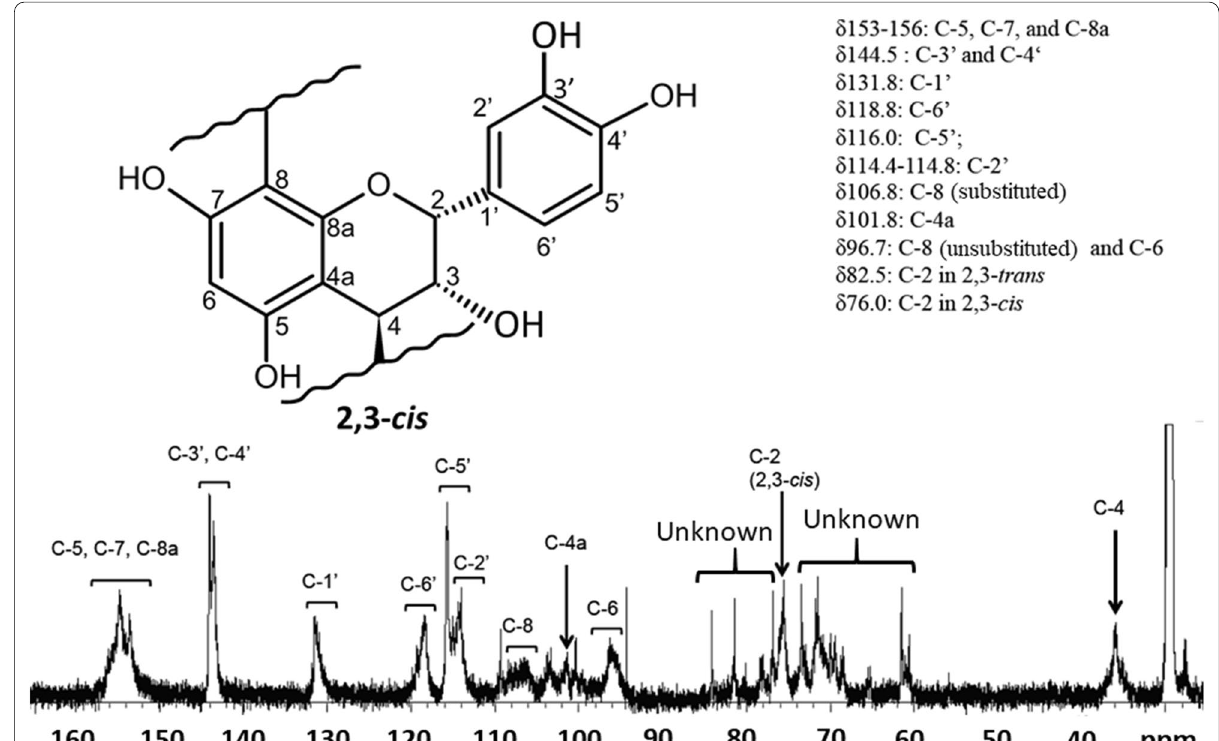
Fig. 6 Solution-state 13 C-NMR spectrum of proanthocyanidin polymer preparation of aqueous extracts of A.